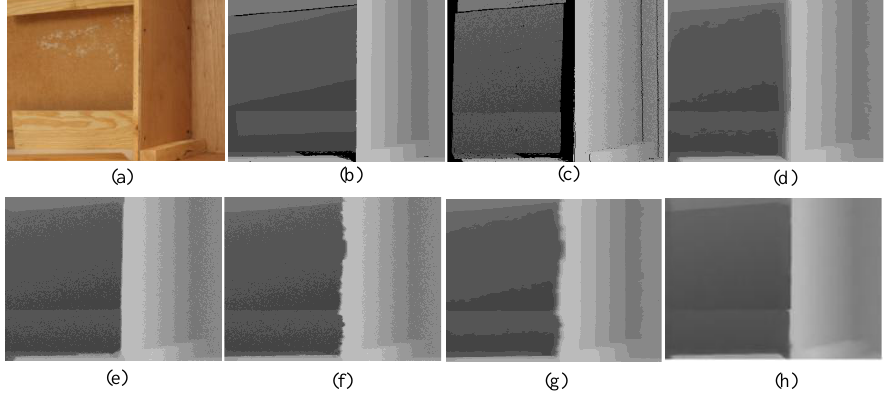
Figure 18. Results for Wood from the Middlebury database: ( a ) Color image; ( b ) Original depth map (right view); ( c ) Noisy image; ( d ) JBF; ( e ) FMI; ( f ) GFMI; ( g ) GFMIGF; ( h ) Proposed method.